Question: Draft a figure caption describing what is shown.
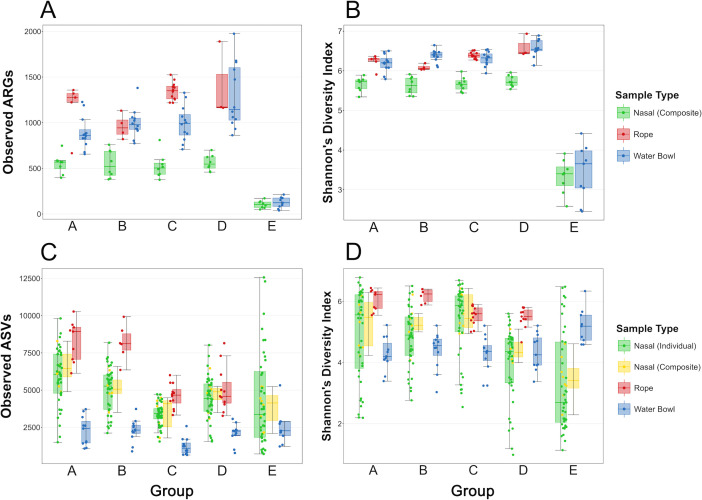
Answer: Alpha diversity of the resistome and microbiome across sample types and cattle groups. Panels A and B: resistome alpha diversity measured at the ARG accession level, showing observed ARG richness ( A ) and Shannon’s diversity index ( B ). Panels C and D : microbiome alpha diversity measured at the ASV level, showing observed ASV richness ( C ) and Shannon’s diversity index ( D ). Boxplots are stratified by cattle group (A–E) and sample type (nasal individual, nasal composite, rope, and water bowl, as indicated by color). Nasal swabs had significantly lower ARG richness and diversity ( A and B ), and nasal swab and water bowl samples had significantly lower microbial community richness and diversity compared to ropes ( C and D ). Group E nasal swabs and water bowl samples had markedly different ARG richness and diversity compared to other cattle groups ( A and B ). Statistical comparisons (Wilcoxon rank-sum tests and adjusted P values) are described more fully in the text.